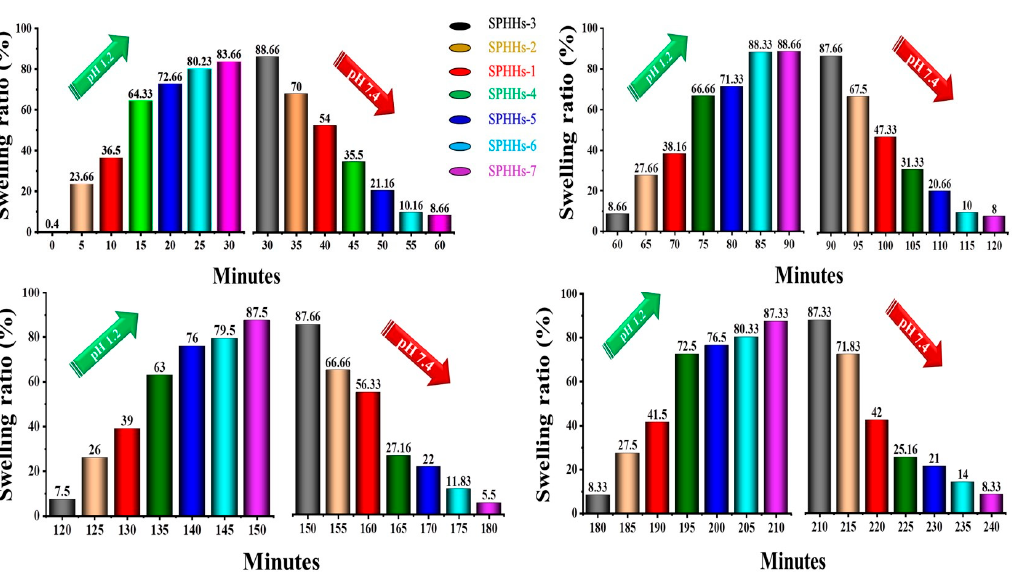
Figure 3. The pH-dependent swelling ratio (%) from the interchange of the medium between (pH 1.2) HCl and (pH 7.4) PBS ( n = 3, mean ± standard deviation). The swelling ratio versus time measures the different levels of pH absorbed into the SPHHs structure. While this indefinitely reflects the weight of the SPHHs in their dry and fully swollen states, the sample behavior within this period reflects the swelling